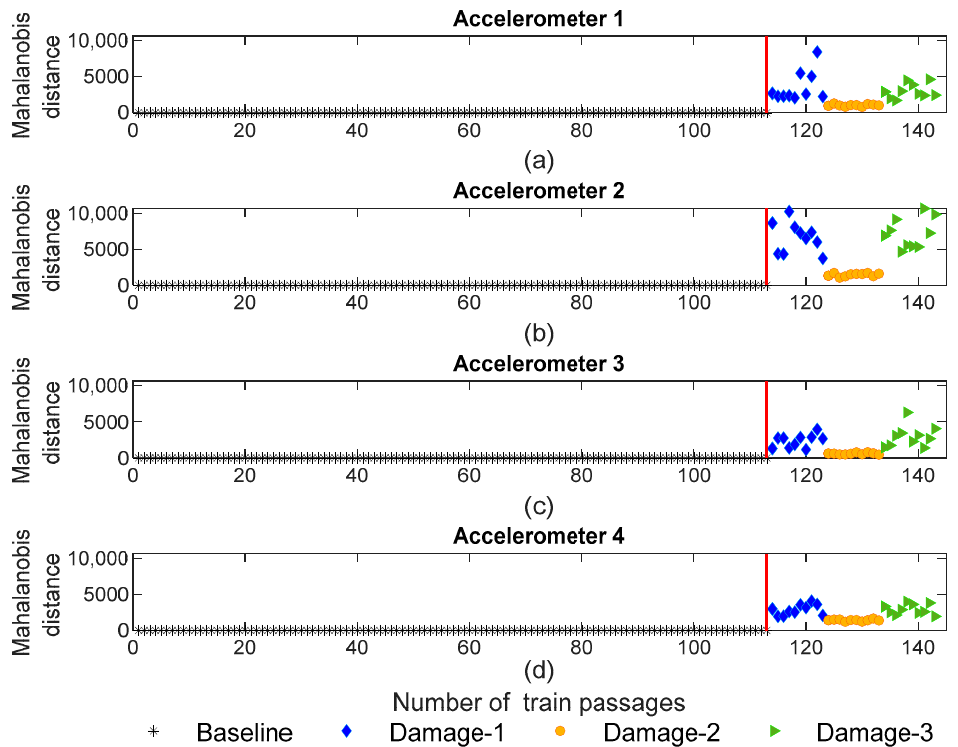
Figure 17. ARX—data fusion for all 143 baseline and damage scenarios: ( a ) MD for accelerometer 1, ( b ) MD for accelerometer 2, ( c ) MD for accelerometer 3, ( d ) MD for accelerometer 4.